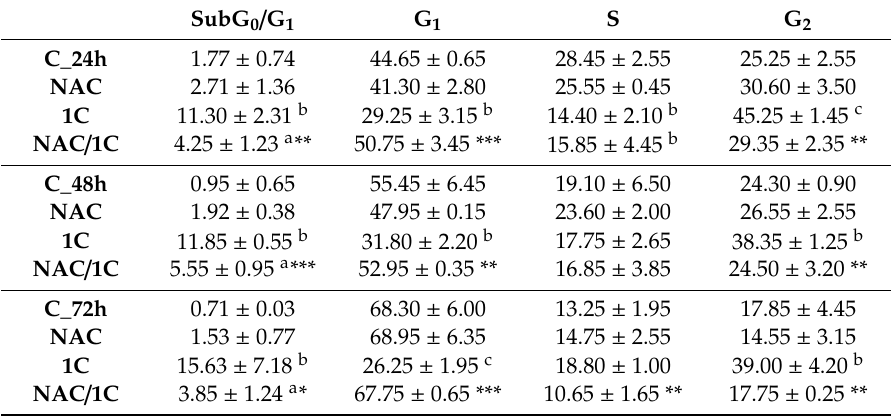
Figure 5. Representative histograms of cell cycle distribution in HCT116 cells treated with NAC, 1C, or NAC / 1C after 24, 48, and 72 h. Table 3. Cell cycle analysis of HCT116 cells after 24, 48 and 72 h incubation with NAC, 1C, or NAC /